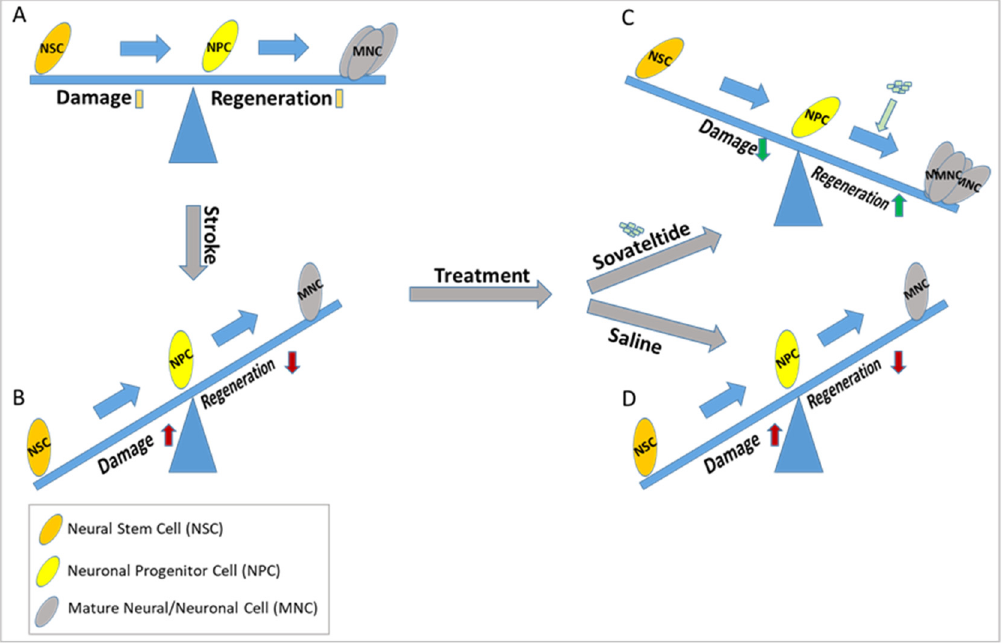
Figure 2. Diagrammatic representation of the effect of sovateltide on neuronal progenitor cell differentiation and neural regeneration after cerebral ischemic stroke. ( A ). Normal homeostasis, ( B ). Higher damage than regeneration (probably due to less differentiation of NPCs), ( C ). Higher regeneration and lower damage after sovateltide treatment (probably due to higher NPCs differentiation), which remains similar after saline treatment ( D ).